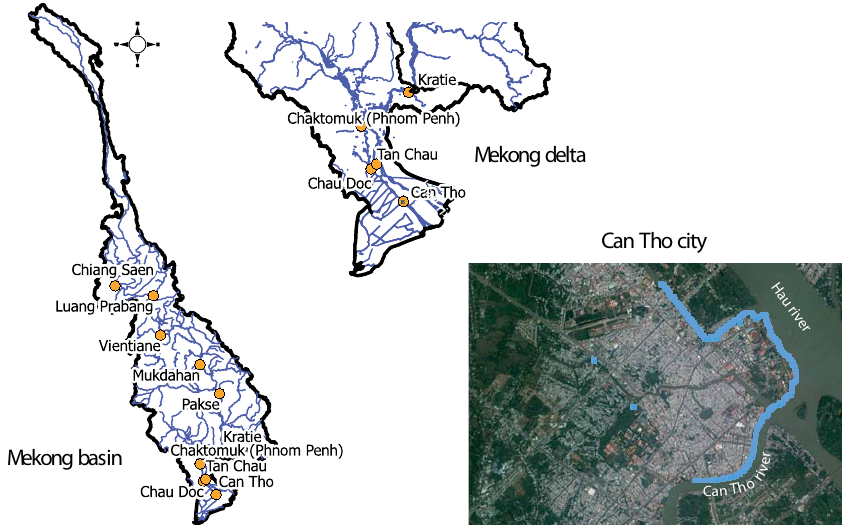
Figure 1. Sketch of the geographical setting of the study: the whole Mekong basin, the Mekong Delta with the main gauging stations, and Can Tho city. The area shaded in grey in the Can Tho city image shows the modelling domain and the blue dots indicate the fluvial boundaries of the hydraulic